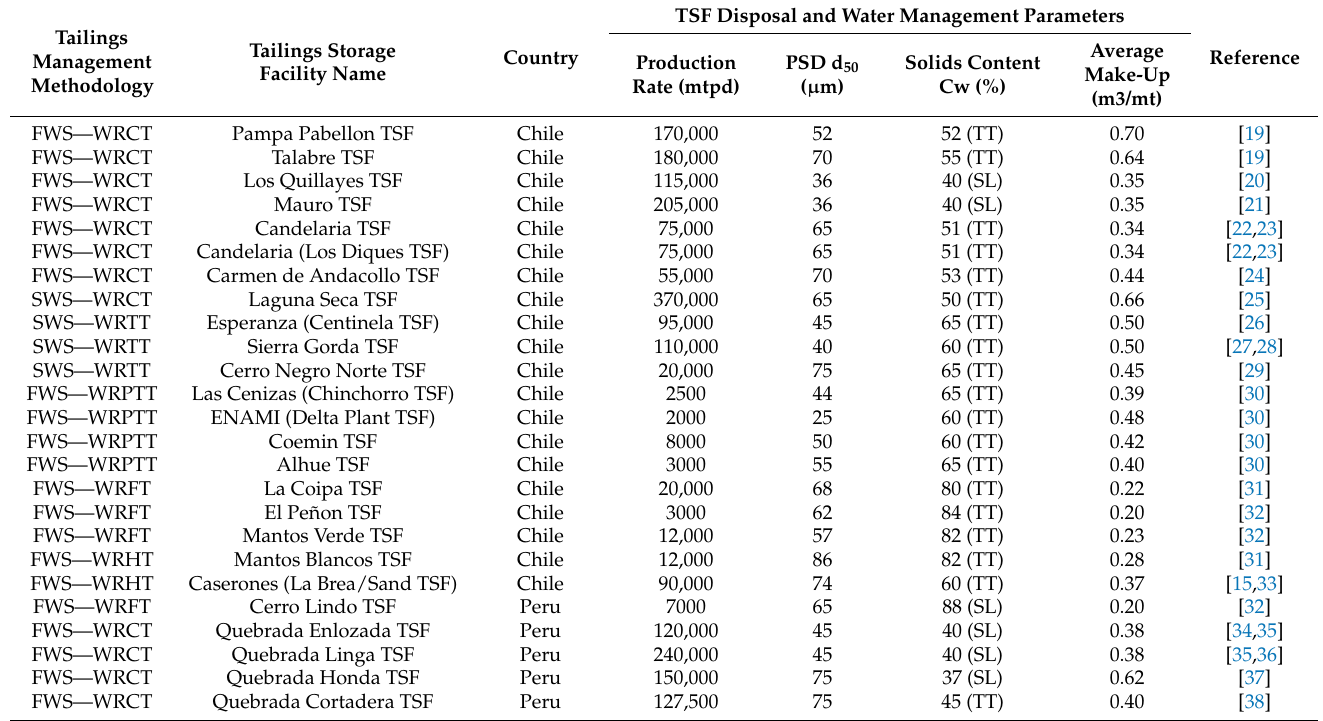
Table 1. Tailings management methodologies and average water make-up (TSF water